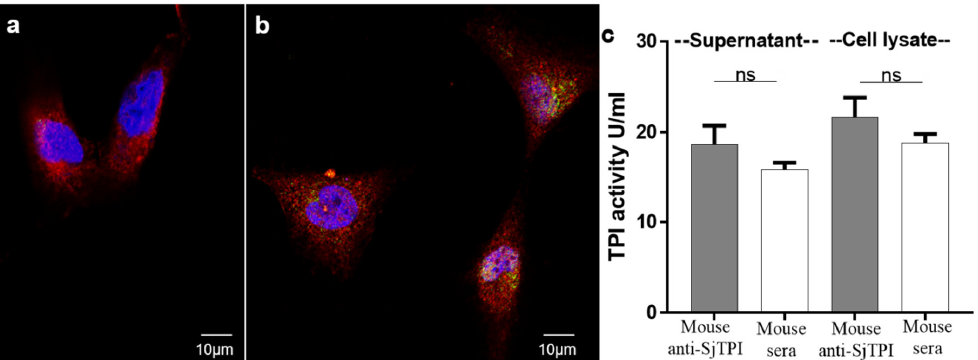
Figure 6. Immunofluorescence staining of SjTPI in hepatic stellate cells (HSC). Permeabilized HSC, after blocking with DAKO, were incubated with rabbit anti-actin antibody mixed with ( a ) naïve mouse serum or ( b ) mouse anti-rSjTPI serum. HSC from A and B were then incubated with a mixture of goat anti-mouse Alexa-488 (labeled with green fluorescence dye) and goat anti-rabbit Alexa-647 (labeled with red fluorescence dye). HSC nuclei were stained blue with DAPI. ( c ) TPI activity assays of supernatants and HSC lysates after culture in DMEM containing 5% ( v/v ) mouse anti-SjTPI serum or naïve mouse serum.